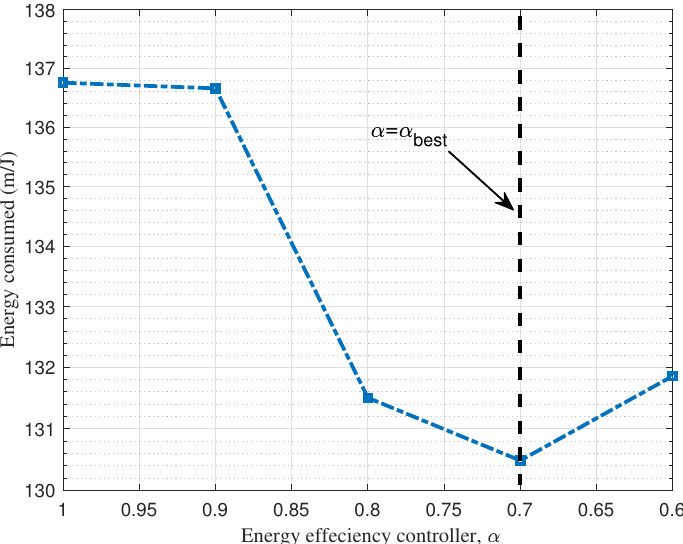
Figure 2. Energy consumped vs. energy-efficiency controller α in urban scenario with 100 LoRa